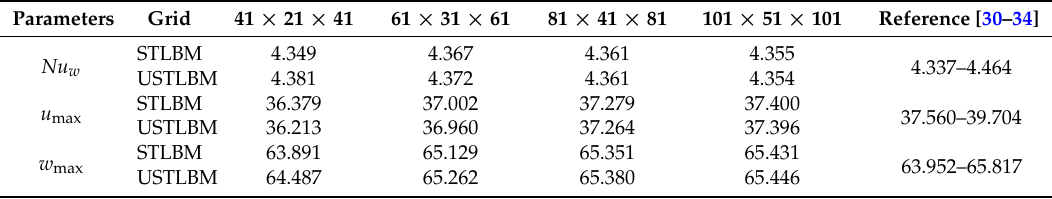
Table 7. Comparisons of flow parameters for 3D natural convection in Ra = 10 5